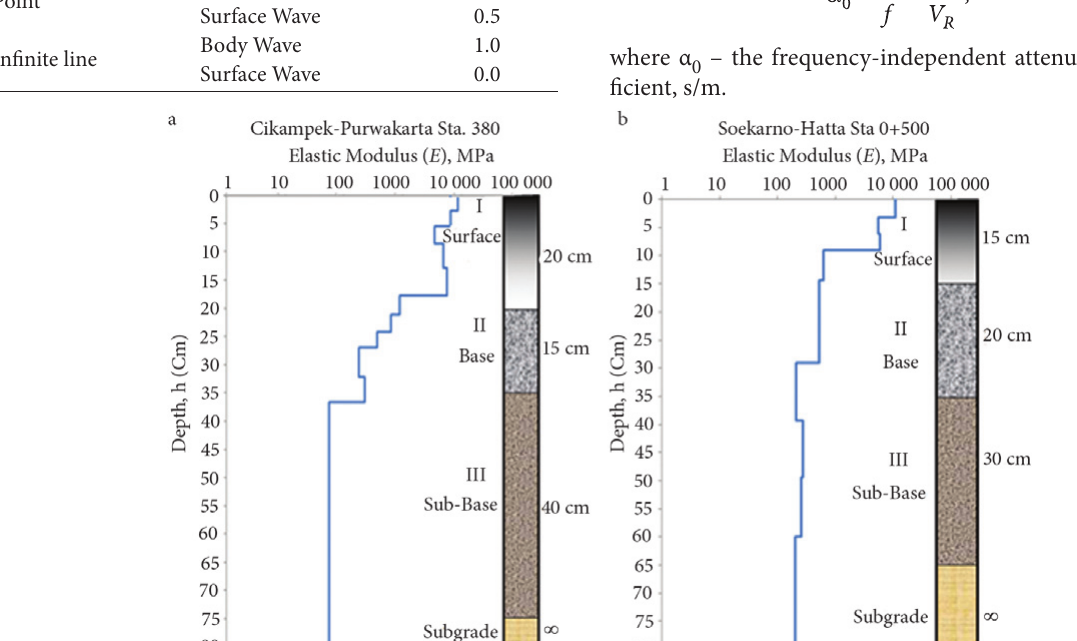
fig. 7. The elastic modulus profile from the inverted-shear wave velocity profile for: a – Cikampek–Purwakarta State Road; b – Soekarno–Hatta State